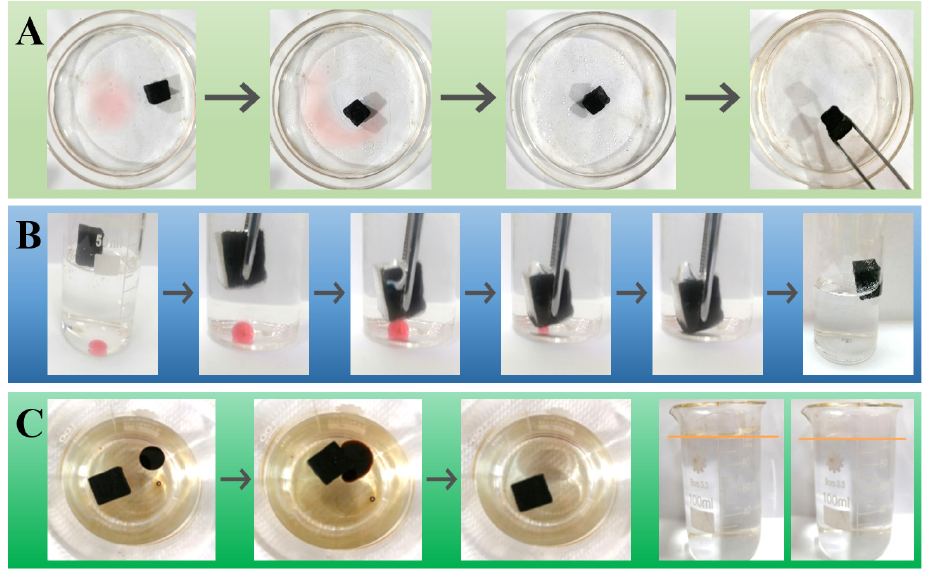
Figure 7. Removing oil from the top surface ( A , C ) and subsurface ( B ) of water using the m-AS/Ka- olin@MS. The oil contaminants were the n-hexane (( A ), colored by Sudan IV), chloroform (( B ), col- ored by Sudan IV), and crude oil ( C ).